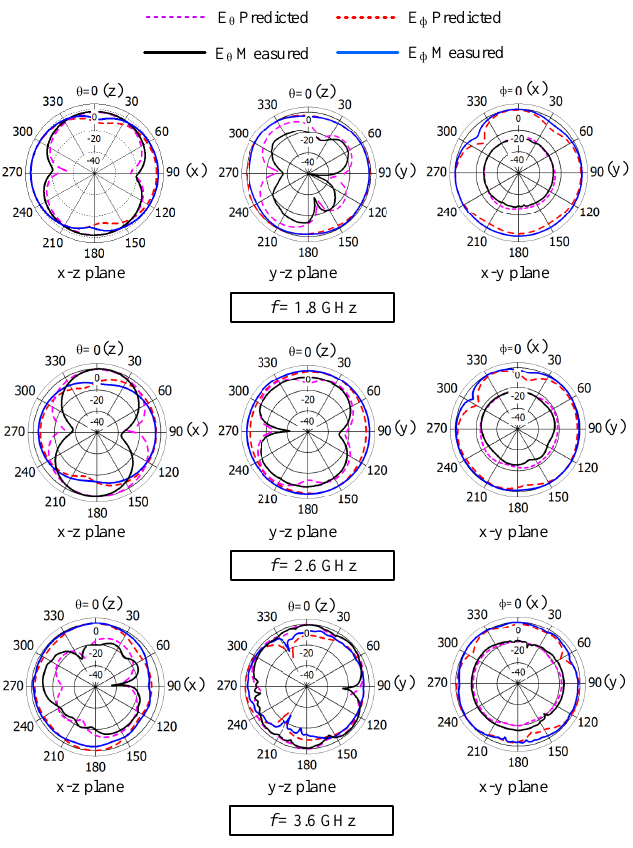
Figure 19. Measured and predicted normalized radiation patterns of the wideband antenna (Ant#3) at 1.8, 2.6, and 3.6